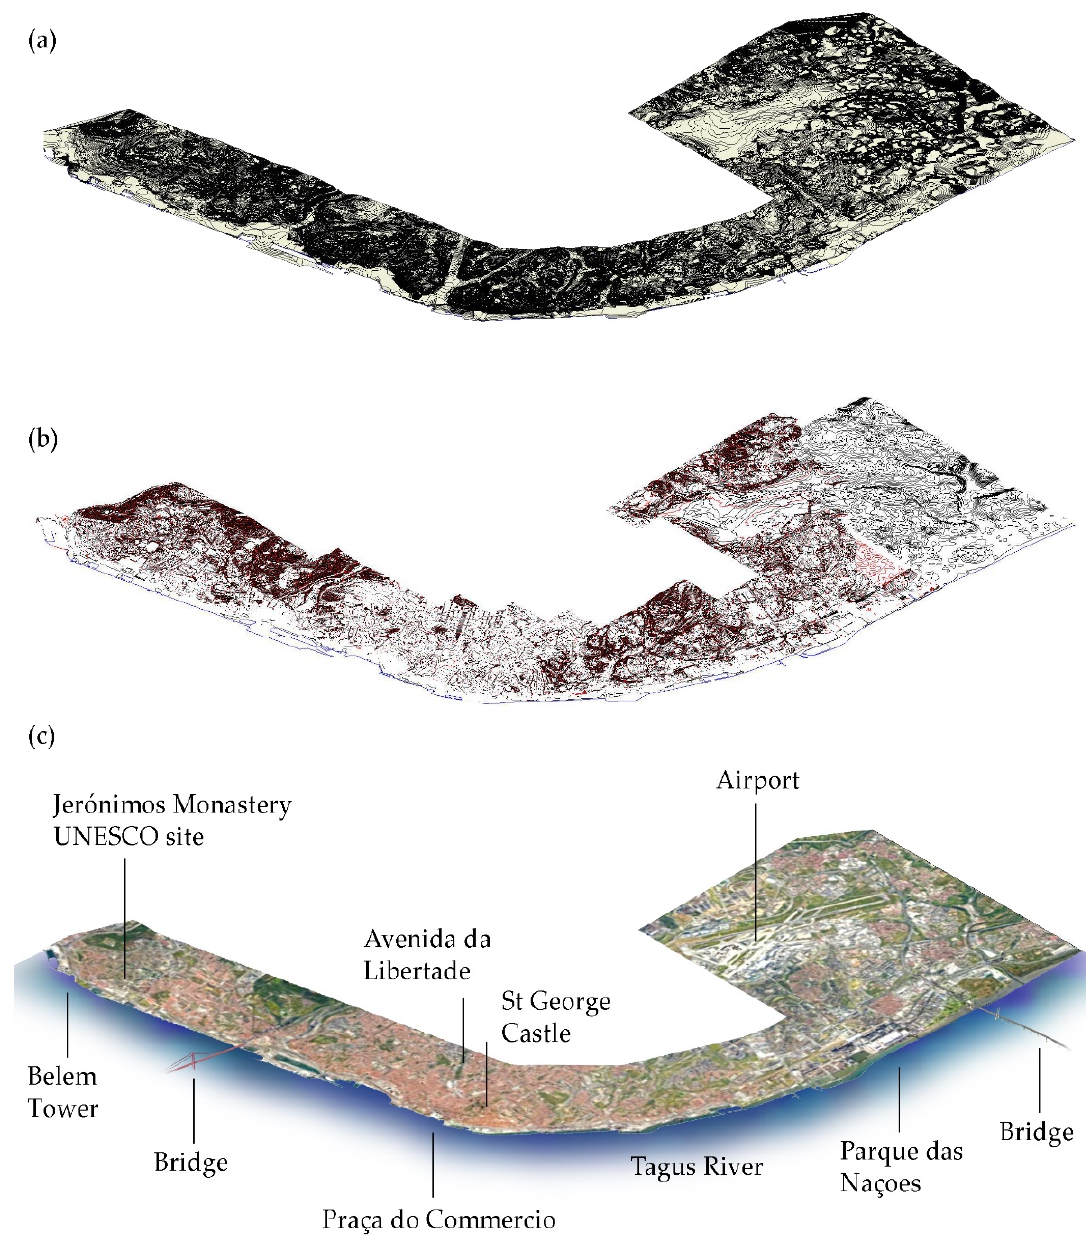
Figure 7. Scope of the research area. A CAD file with the altimetry of the city of Lisbon was scrubbed of the unneeded layers, purged and linked to the BIM file, and subsequently used for the automatic generation of the toposurface. ( a ) The 3D terrain modelled in Autodesk Revit in all its extension. ( b ) Curves and point observations taken from the cartography 1:1000. ( c ) Satellite view of the research area in which are highlighted some important spots as visual reference in the Lisbon council.